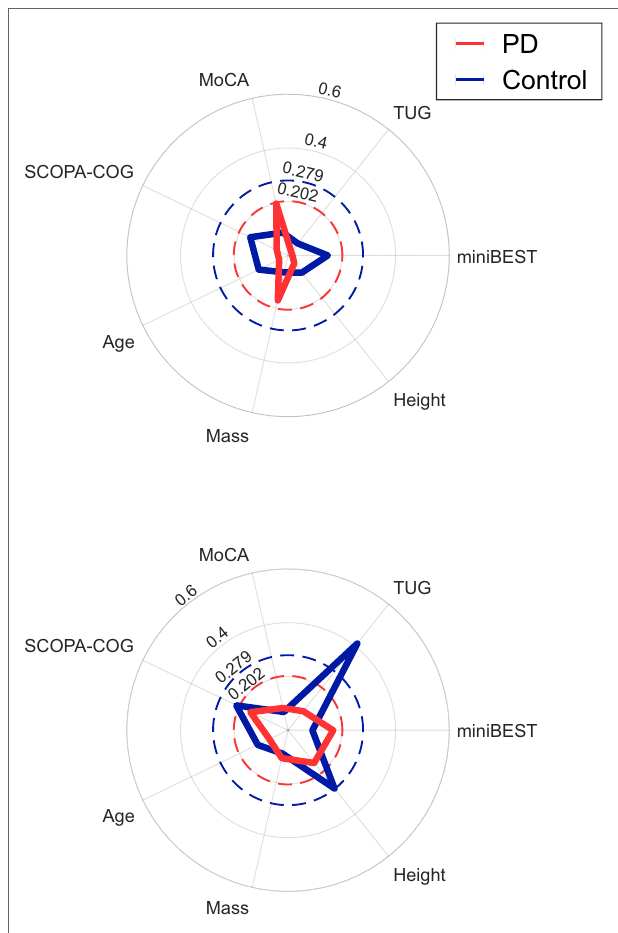
FigUre 4 | Radar plots of the absolute value of Spearman’s correlation coefficients between demographic and clinical outcomes and the %DTCs of λ HC (top) or time in late swing (bottom). The dashed red and blue circles indicate the critical ρ value for p = 0.05 for Parkinson’s disease (PD) and control groups, respectively. The %DTC for time in late swing was significantly associated with TUG time in controls only ( ρ = 0.41, p = 0.004). There were no other significant correlations ( p >